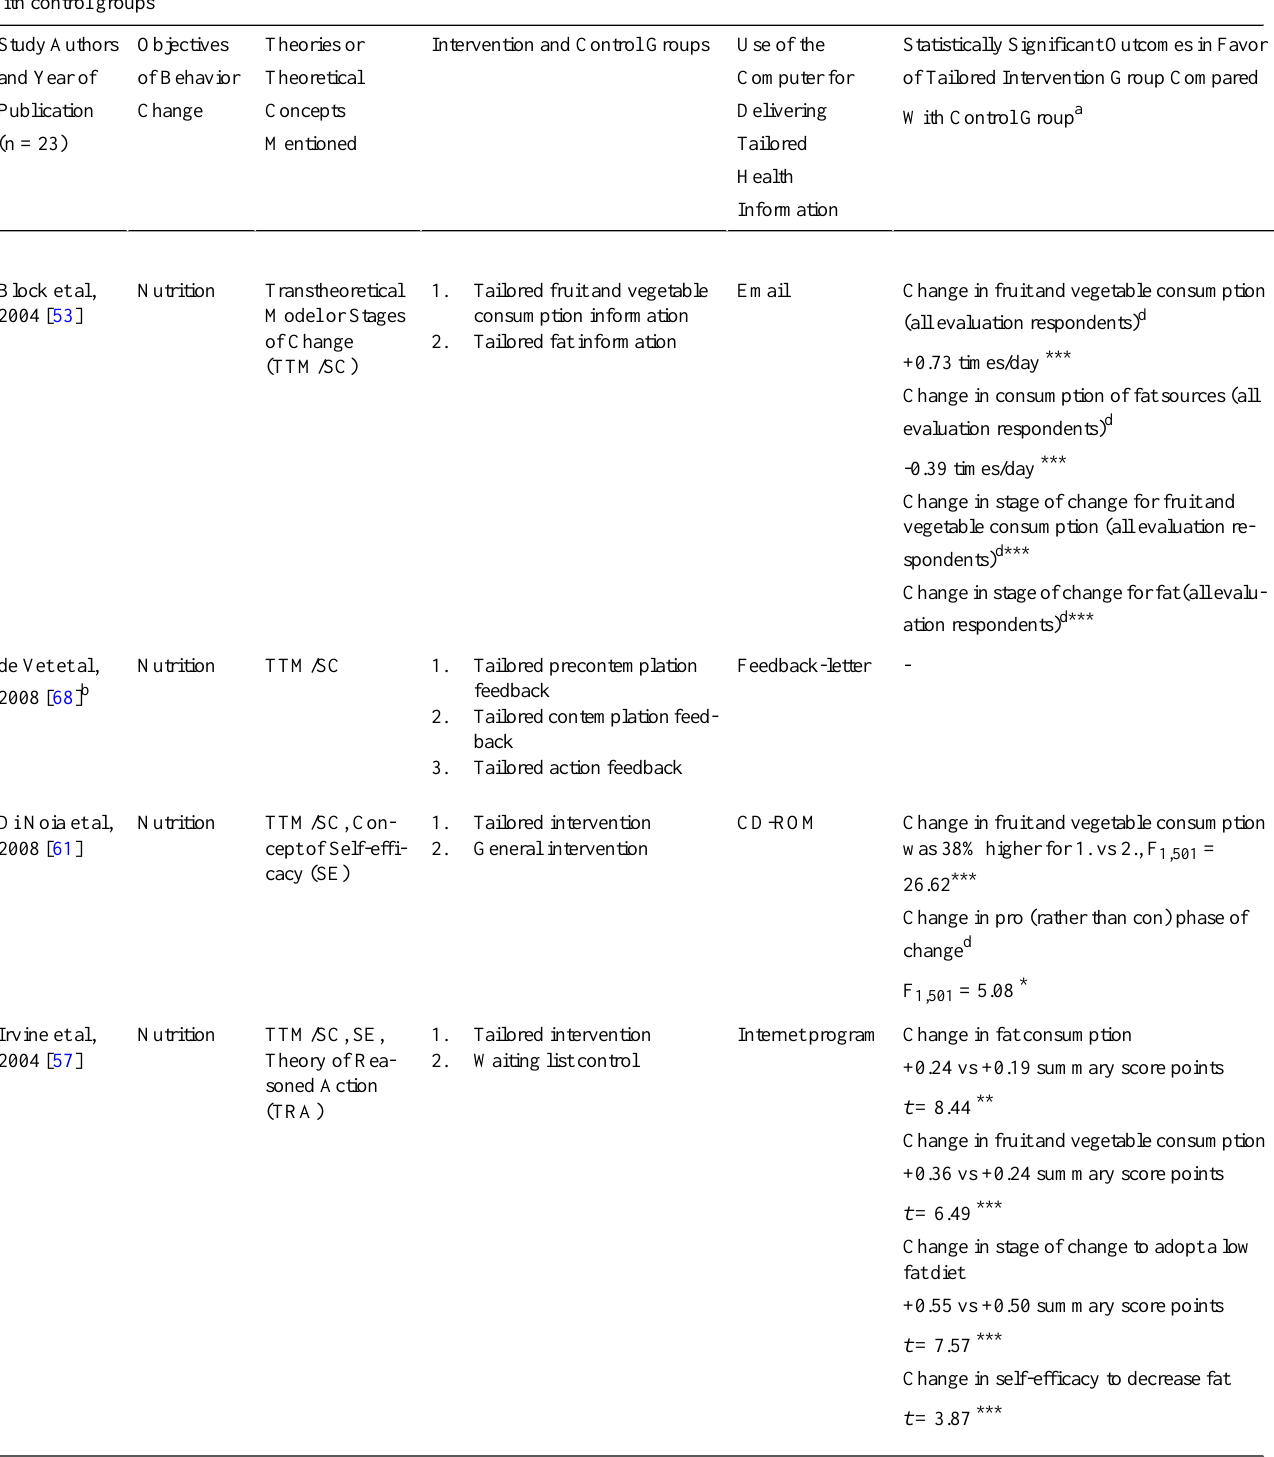
Table 2. Objectives of behavior change, theories, intervention designs, and statistically significant outcomes of the tailored intervention groups compared with control